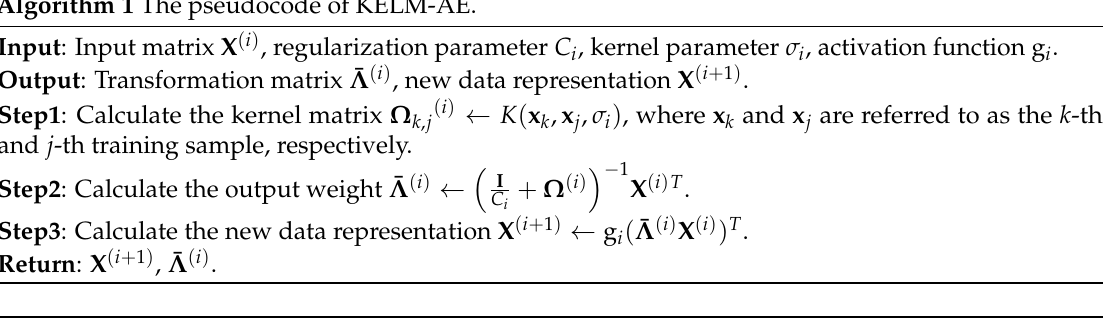
Algorithm 2 The pseudocode of